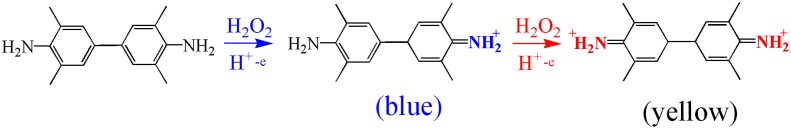
The oxidation reaction of TMB.